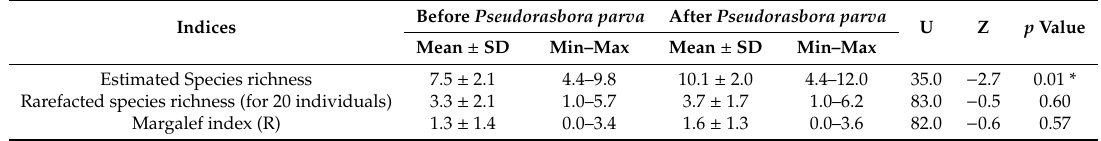
Table 5. Characteristics of diversity indices (mean, standard deviation (SD), and minimum (Min) and maximum (Max)) before and after Pseudorasbora parva was found in the Ciemi ę ga River; U, Z—the statistics of a Mann–Whitney test.